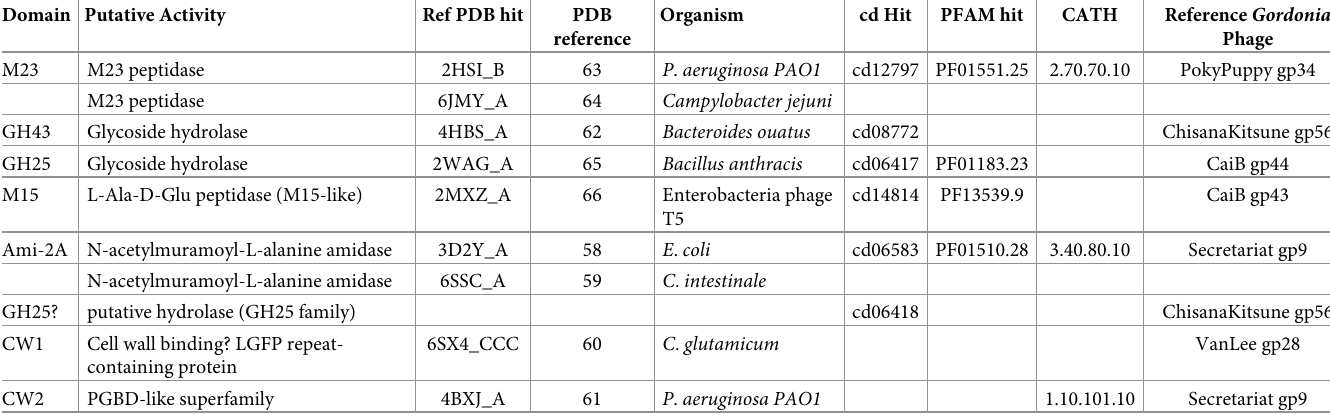
Table 3. Domain features of bioinformatically-defined Gordonia phage endolysin (LysA) domains.